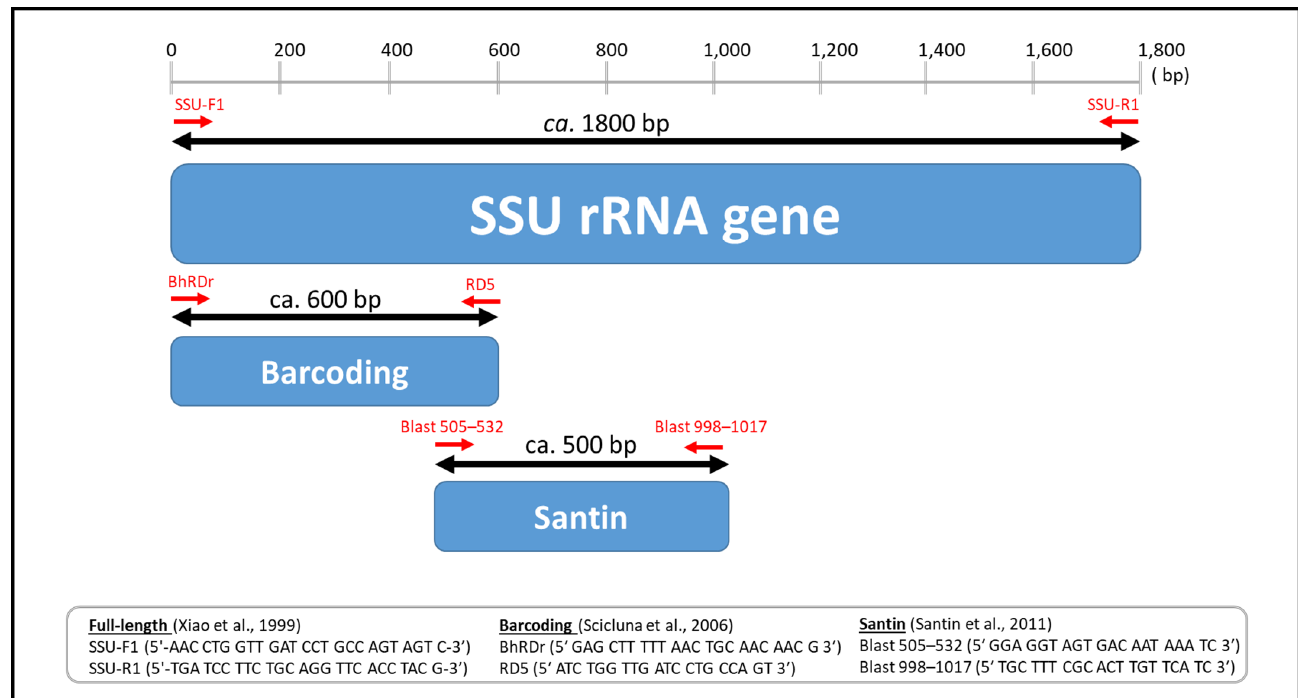
Figure 1. Diagram showing small subunit ribosomal RNA ( SSU rRNA) gene indicating regions amplified by barcoding and Santin primers as well as information on primers used to amplify all gene segments used in this study.